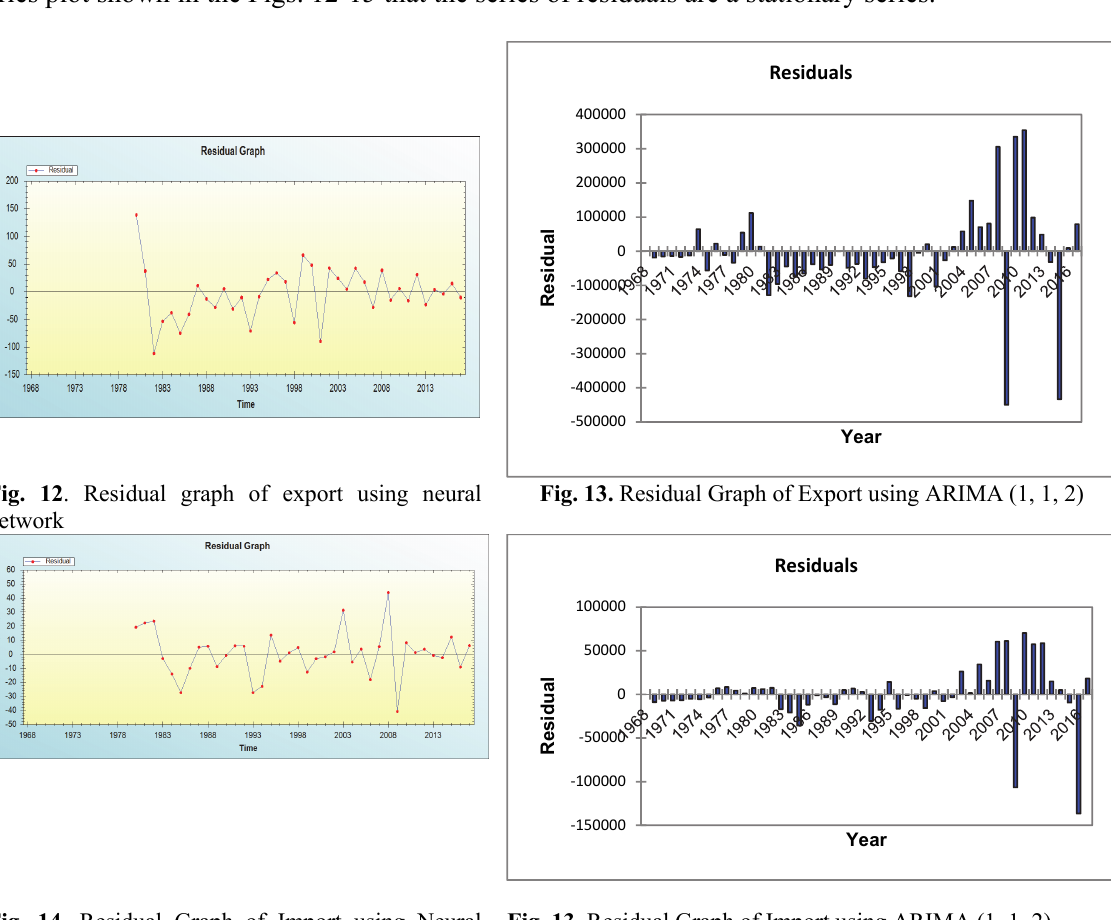
Fig. 13. Residual Graph of Import using ARIMA (1, 1,